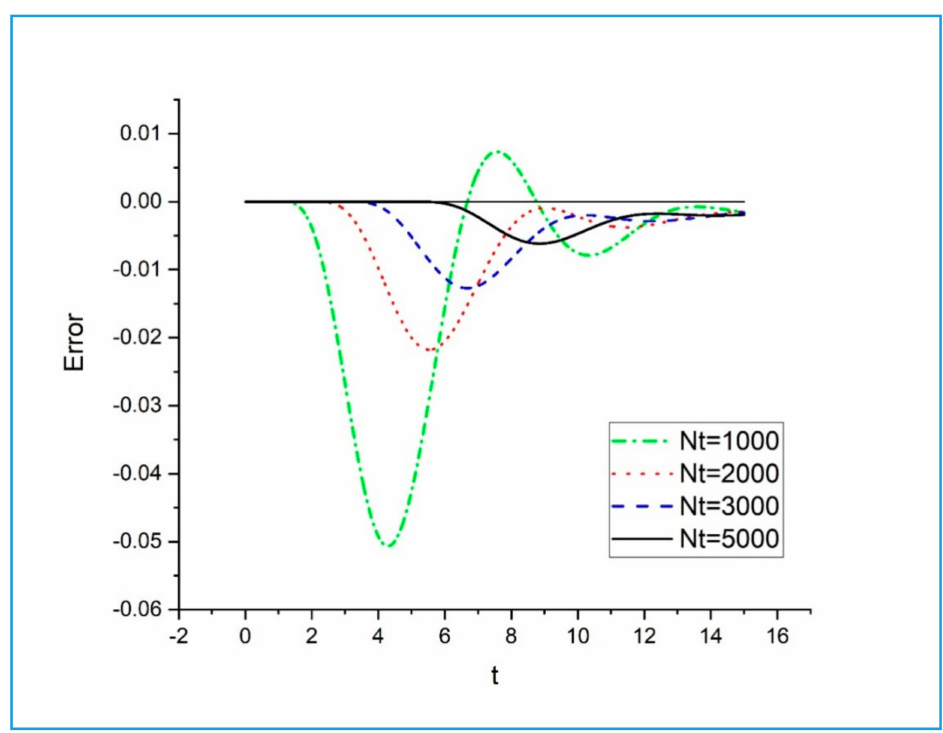
Figure 3. The errors between the SMP numerical solution ( Nt = 1000, 2000, 3000, 5000) and the original definition numerical solution (No truncation) for α = 0.8.